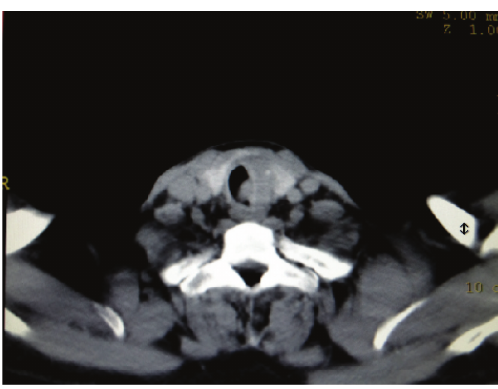
Figure 3: Ultrasonogram of thyroid showing calcifications with hypoechoic lesion